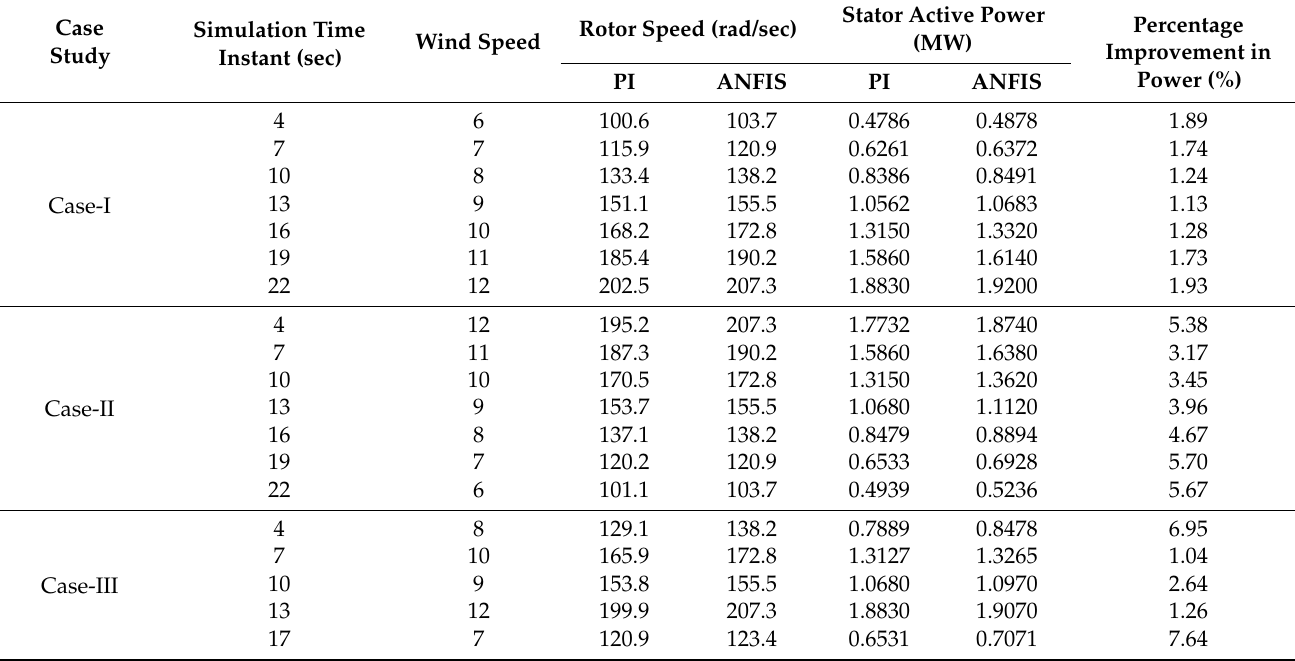
Table 8. Performance comparison of ANFIS and PI